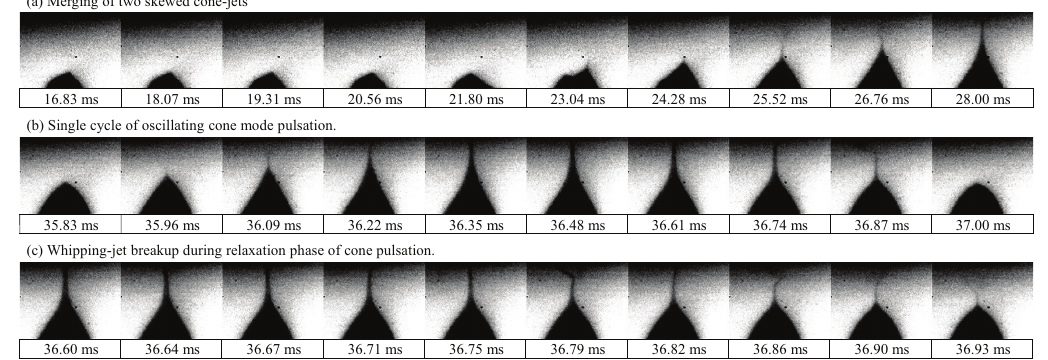
Figure 8. Voltage-induced startup image sequences, 400pLs − 1 flow, 0kV to 1.6kV emitter bias; voltage is switched on at 0ms. ( a ) Onset of emission transient. Two highly off-axis cone-jets merge into a single emission site that immediately enters intermittent cone-jet mode. ( b ) Single cycle of pulsation after onset of emission. ( c ) Whipping jet breakup that occurs during relaxation period of the pulsation cycle. Figure modified from Ref. [43].